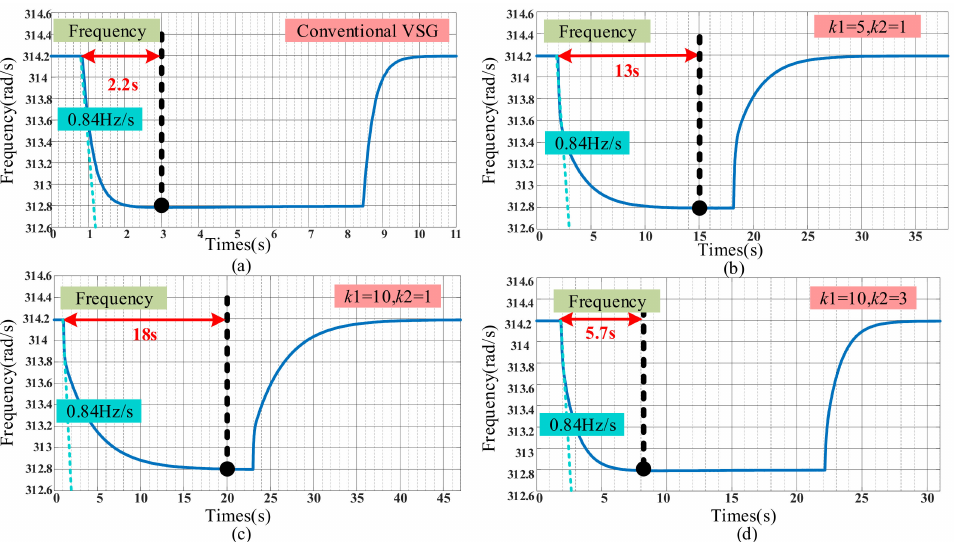
Figure 18. Experimental results of frequency in SA mode ( a ) conventional VSG ( b ) k 1 = 5, k 2 =